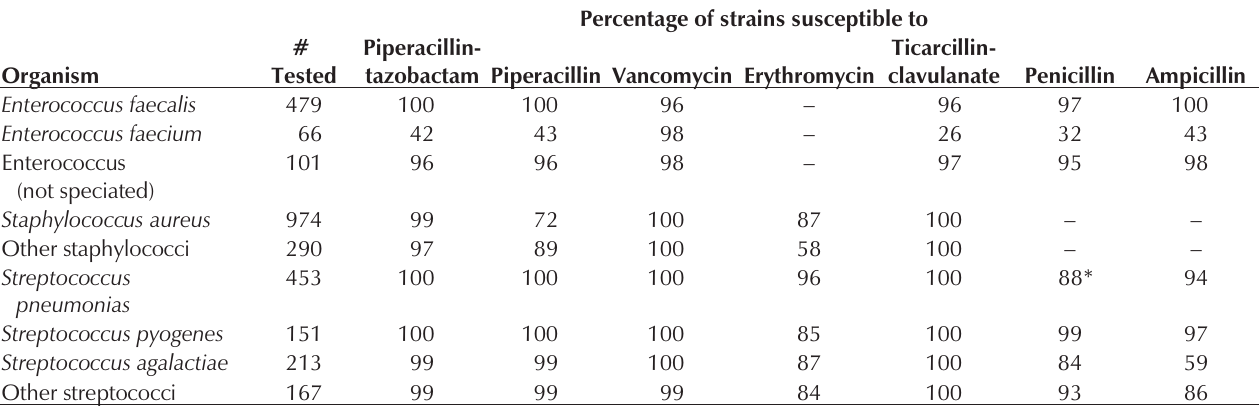
Comparative activity of piperacillin-tazobactam and other parenterally administered antibiotics against 2074 Gram-positive organisms isolated at 61 Canadian hospitals